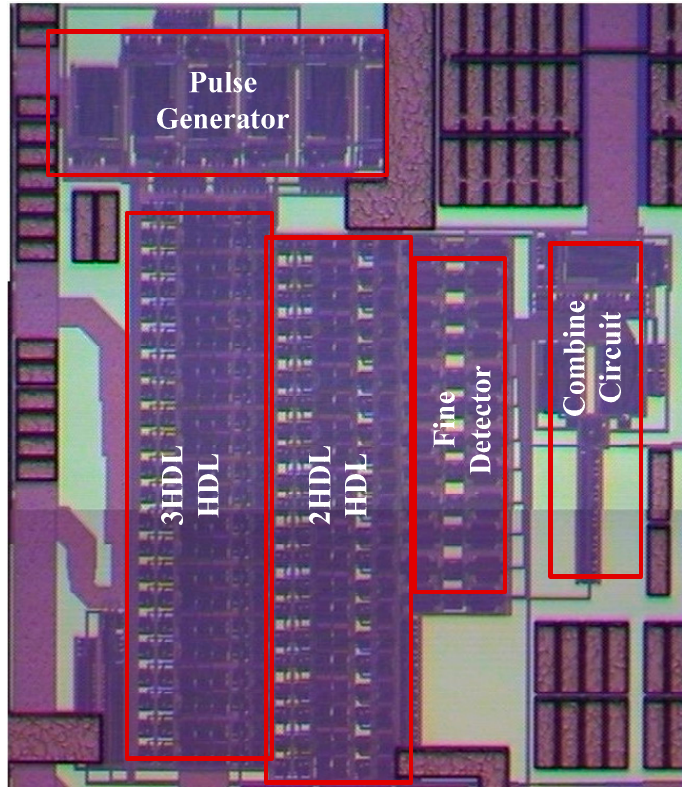
Figure 8. Chip micrograph.